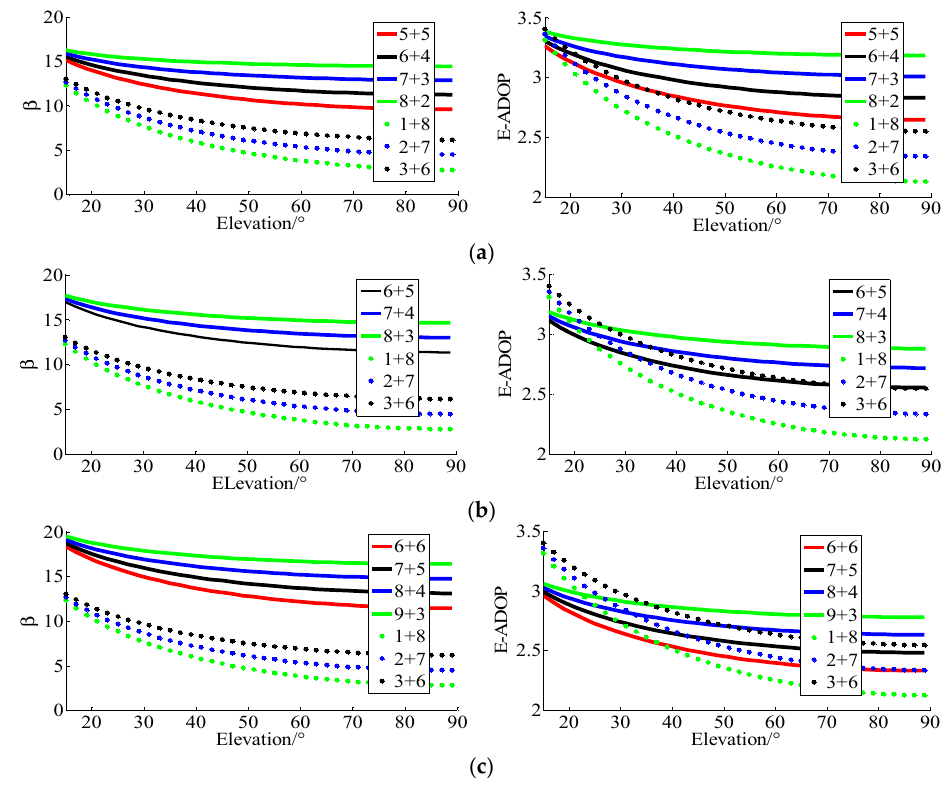
Figure 3. Factor β and E-ADOP of three groups of satellites for different elevations. ( a ) The β and E-ADOP of n 1 + n 2 = 10 and n 1 + n 2 = 9 satellites. ( b ) The β and E-ADOP of n 1 + n 2 = 11 and n 1 + n 2 = 9 satellites. ( c ) The β and E-ADOP of n 1 + n 2 = 12 and n 1 + n 2 = 9